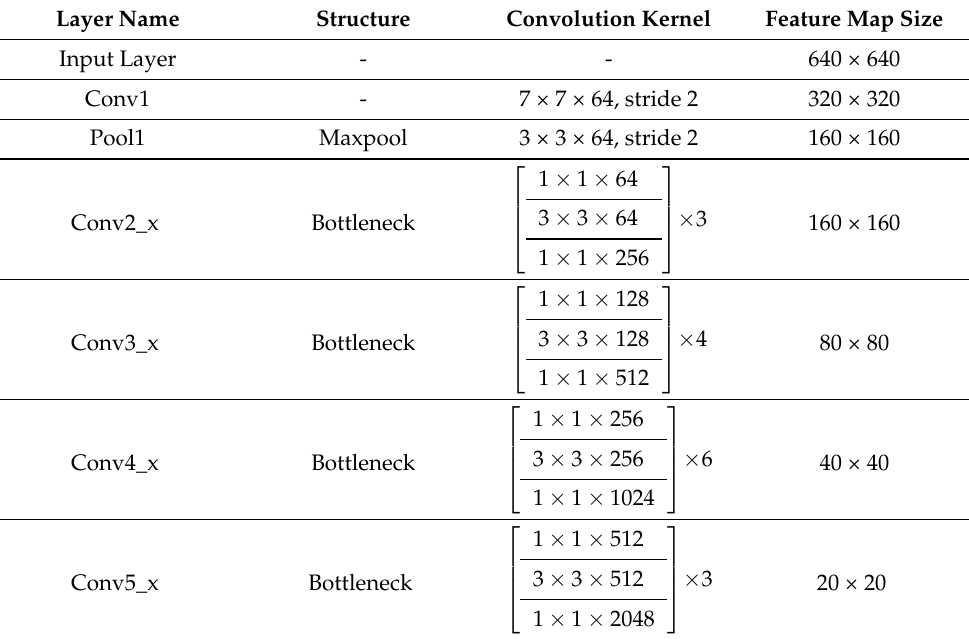
Table 1. The description of specific backbone configuration